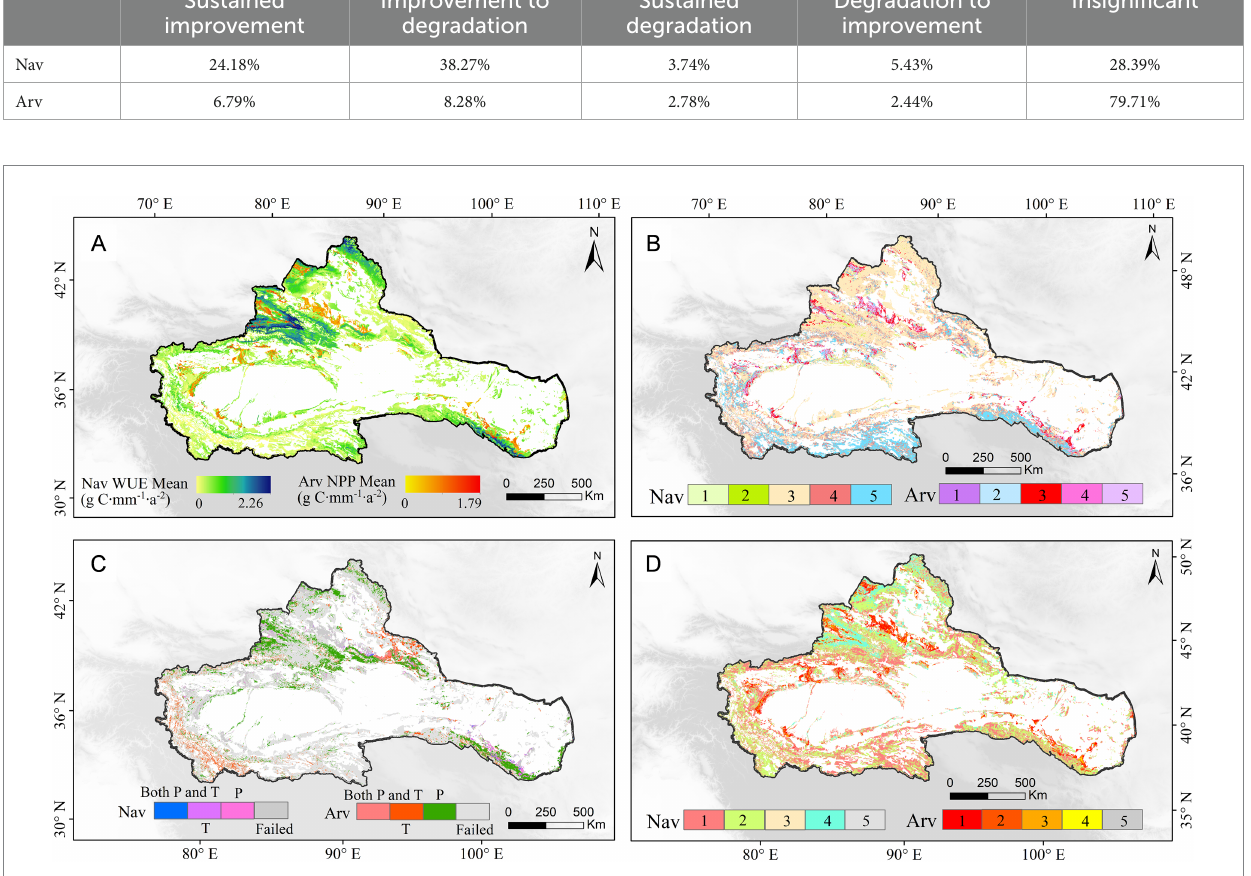
FIGURE 5 Water use efficiency of natural vegetation in China’s arid northwest region from 2001 to 2018: ( A ) period-mean WUE; ( B ) long-term trend of WUE (1. Extremely significant decrease, 2. Significant decrease, 3. No significant change, 4. Significant rise, 5. Extremely significant rise); ( C ) primary factors regulating interannual variations of WUE; ( D ) future variation trend of WUE (1. Sustained improvement, 2. Improvement to degradation, 3. Degradation to improvement, 4. Sustained degradation, 5.